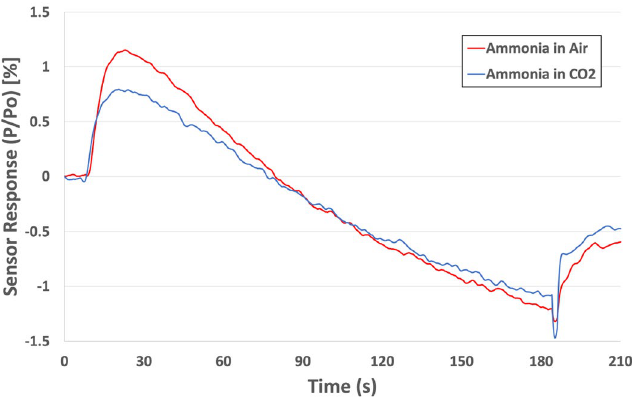
Figure 3. Responses of thermodynamic sensor to 5 ppm of ammonia in air and CO 2 .